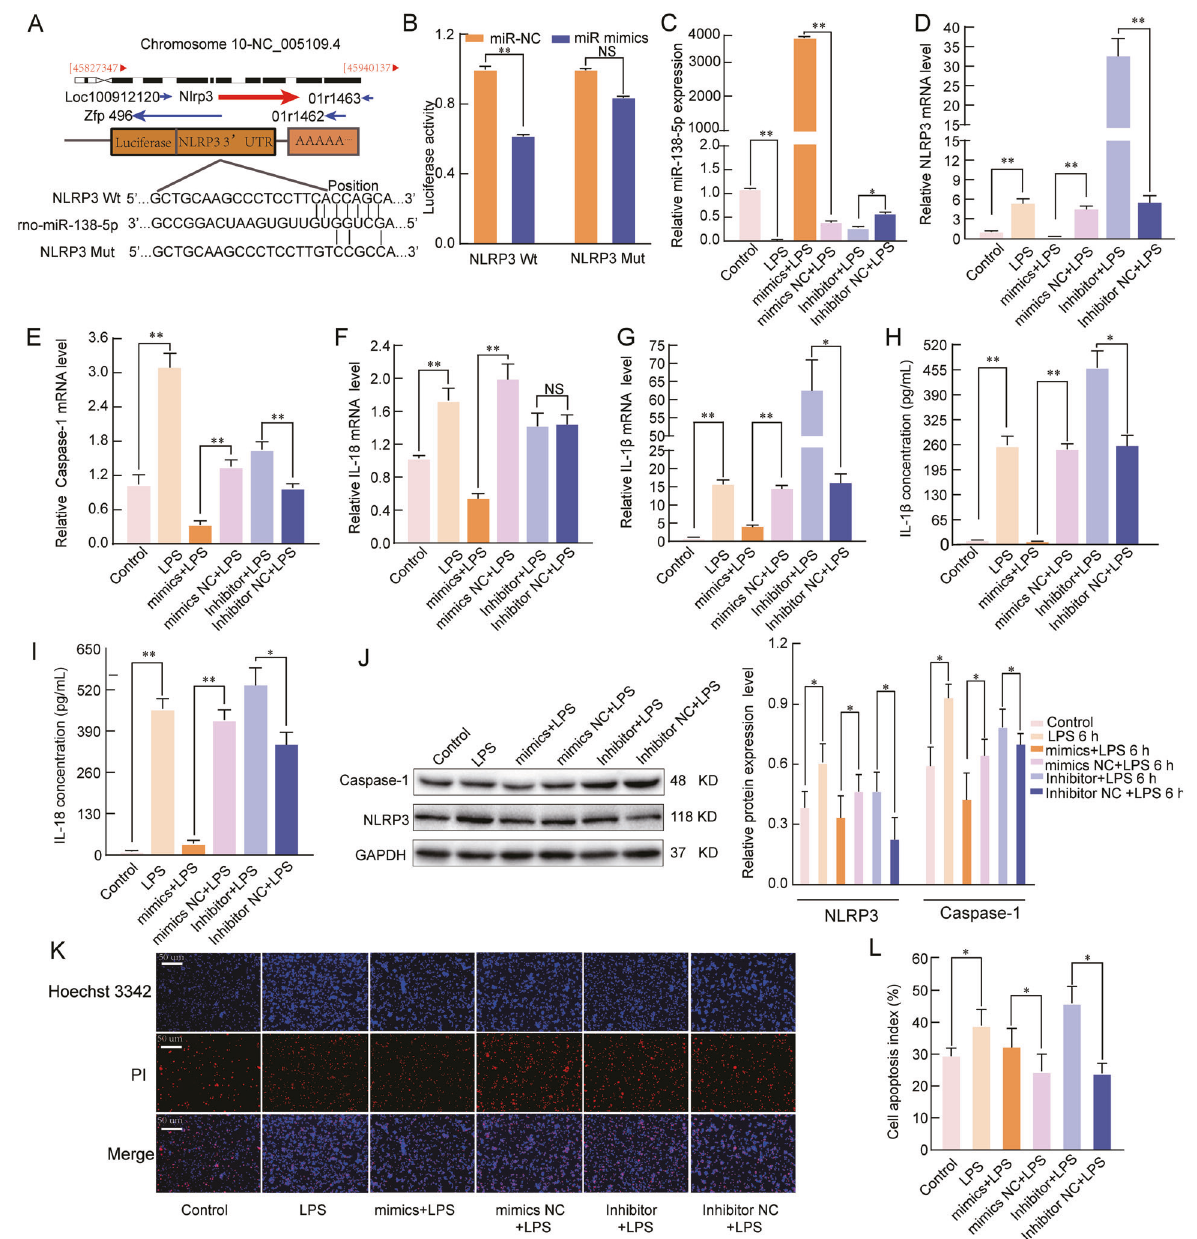
Fig. 5 miR-138-5p regulates the in fl ammatory response by targeting NLRP3. A The predicted miR-138-5p-binding sites in the NLRP3 mRNA 3 ′ -UTR. B A fi re fl y luciferase reporter containing either wild-type or mutant NLRP3 was cotransfected into NR8383 AM cells with miR-138-5p mimics NC or miR-138-5p mimics. qRT-PCR assays were used to analyse the mRNA expression of C miR-138-5p, D NLRP3, E Caspase-1, F IL-18, and G IL-1 β in the NR8383 AM cells ( n = 6). β -Actin was used as a reference gene. H , I ELISA was used to analyse the IL-1 β and IL-18 levels in the culture supernatants. J Western blotting assay of the protein expression levels of NLRP3 and Caspase-1. K , L Cell apoptosis was determined by Hoechst 33342 and PI dual staining assays ( K ) and counted ( L ). The data are presented as mean ± SE ( n = 6). * P < 0.05; ** P < 0.01; *** P < 0.001; NS, no statistically signi fi cant Fig. 8L. In LPS-treated AM cells, increased lncRNA NLRP3 expression, decreased miR-138-5p expression, increased NLRP3 in fl ammasome activation, and enhanced in fl ammatory responses were observed during ALI. LncRNA NLRP3 acted as a sponge for miR-138-5p to upregulate NLRP3 expression, leading to NLRP3 in fl ammasome activation and subsequent IL-18 and IL-1 β induction in AM cells during ALI. These results indicated that the lncRNA NLRP3/miR-138- 5p/NLRP3 ceRNET exerted pivotal regulatory effects on the in fl am- matory response in ALI.